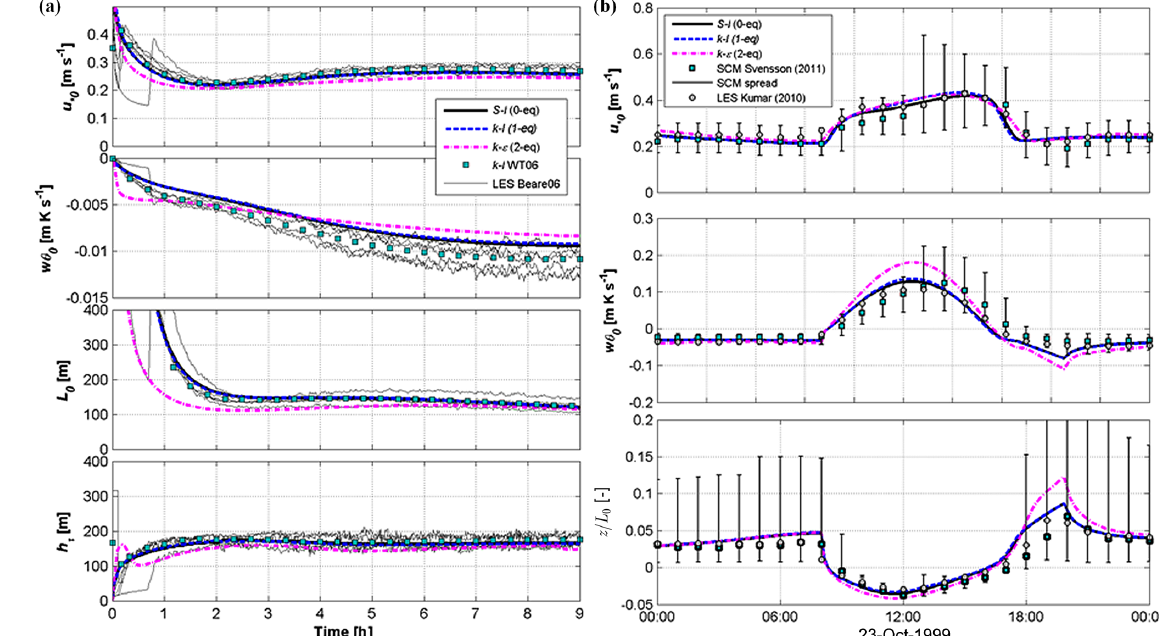
Figure 1. GABLS1 (a) and GABLS2 (b) time series of boundary layer height h τ and surface-layer friction velocity u × 0, kinematic heat flux w(cid:50) 0 , Obukhov length L 0 , and stability parameter z/L 0 . Comparison between SCM simulations using three turbulent closures ( S - l , k - l and k - ε ) and the k - l model of Weng and Taylor (2006), SCM simulations of Svensson et al. (2011), and LES simulations of Beare et al. (2006) and Kumar et al. (2010).